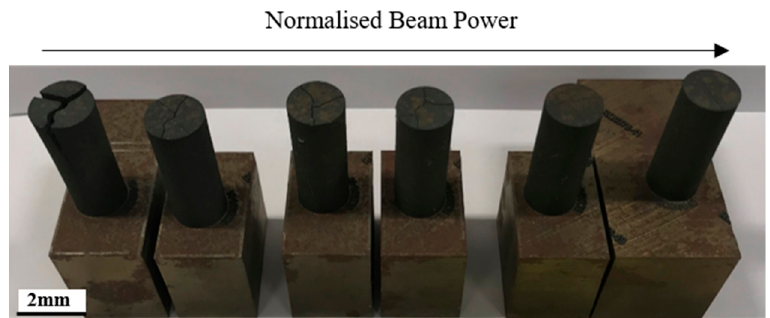
Figure 9. Stitched and blended high-resolution images of material discontinuities in the AB state in relation to normalised beam power.